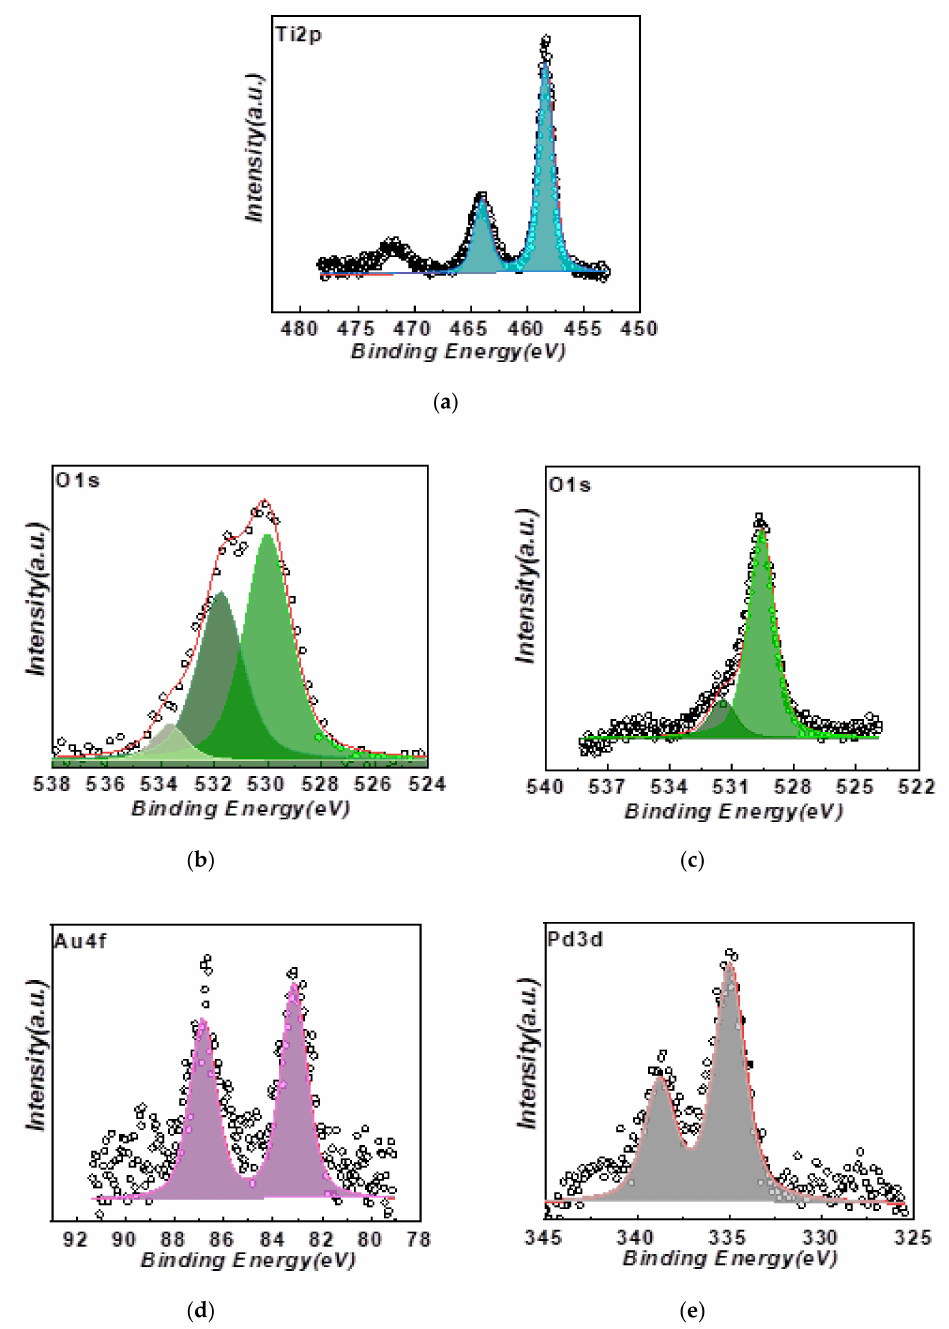
Figure 3. XPS data for DN-FSP materials: ( a ) Ti 2p , ( b ) O 1s , ( c ) O 1s for Pd/TiO 2 , ( d ) Au 4f for Au/TiO 2 and ( e ) Pd 3d for Pd/TiO 2